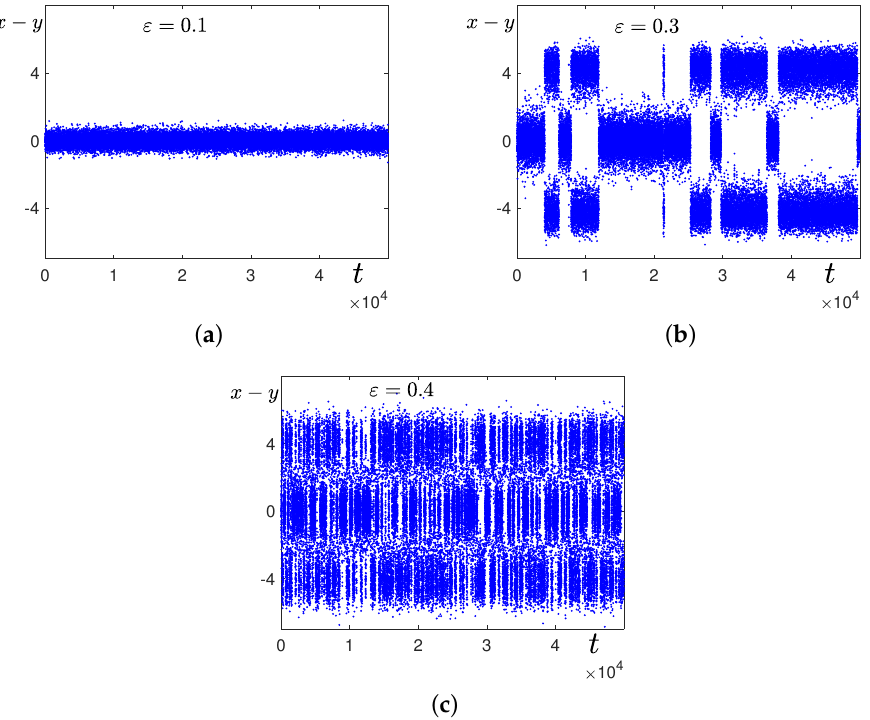
Figure 7. Stochastic system (2) with σ = 0.2 . Time series of difference ( x − y ) for ( a ) ε = 0.1 (noisy syn- chronous state), ( b ) ε = 0.3 (low-frequency intermittency), and ( c ) ε = 0.4 (high-frequency